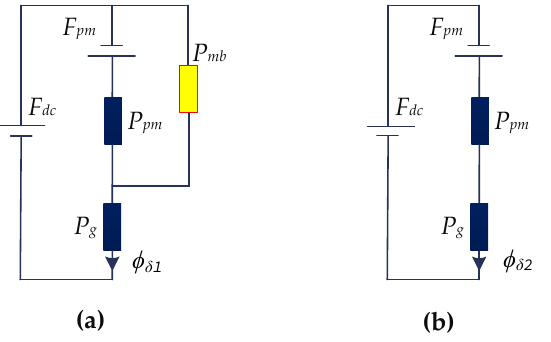
Figure 4. Lumped parameter magnetic circuit models of PS-HEFS machines. ( a ) With iron bridges; ( b ) Without iron bridges.